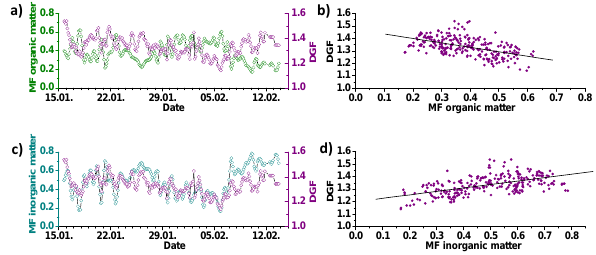
Fig. 4. Correlation between DGF at a RH of 90% and the MF of Figure 4. Correlation between DGF at a RH of 90% and the MF of organic matter in winter 3 organic matter in winter (a) and the inorganic MF in winter (c) with (a) and the inorganic MF in winter (c) with the corresponding scatter plots (b, d). The linear 4 the corresponding scatter plots (b, d) . The linear equation is y = equation is y=-0.36x+1.47 with a correlation coefficient of -0.52 in (b) and y=0.28x+1.2 with 5 − 0 . 36 x + 1 . 47 with a correlation coefficient of − 0.52 in (b) and a correlation coefficient of 0.57 in (d). 6 y = 0 . 28 x + 1 . 2 with a correlation coefficient of 0.57 in (d)